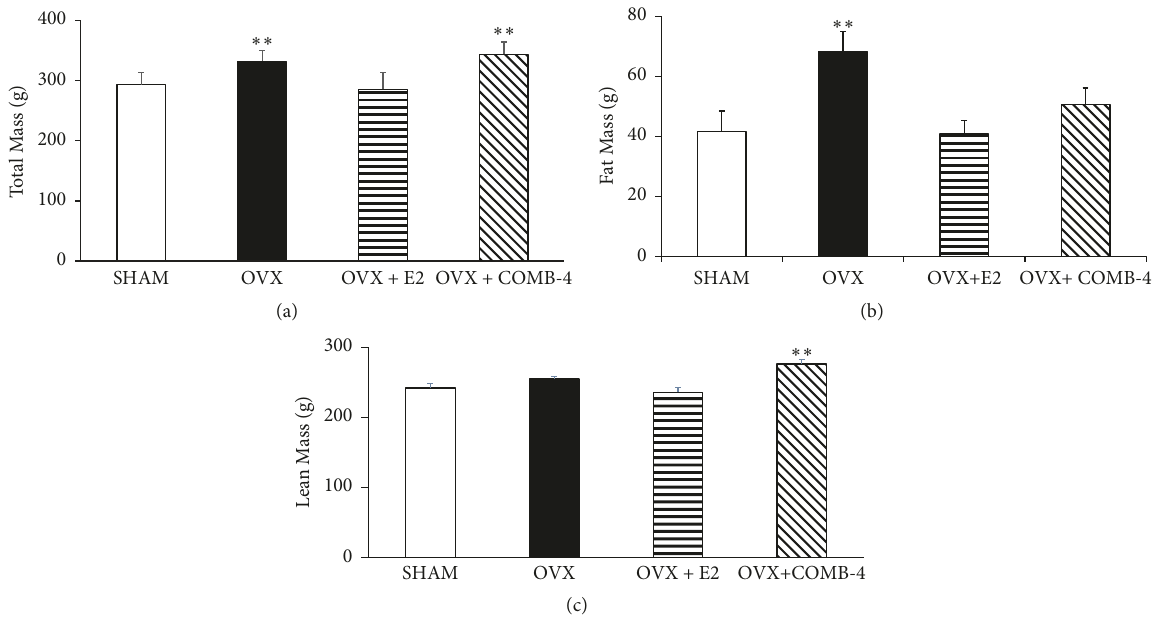
Figure 1: Effect of 100 days treatment with E2 or COMB-4 on Total Body Mass, Fat Mass, and Lean Mass following OVX. Whole body dual energy X-ray absorptiometry (DXA) scan performed 100 days following surgery and subsequent treatment with either vehicle (SHAM and OVX), E2 (OVX + E2) or COMB 4 (OVX + COMB-4). Panel (a): total body mass (g ± SEM); ∗∗ p < 0.01 with respect to SHAM and E2. Panel (b): total fat mass (g ± SEM); ∗∗ p < 0.01; with respect to SHAM, E2, and COMB-4. Panel (c): total lean mass (g ± SEM) ∗∗ p < 0.01 with respect to SHAM, OVX, and E2. n = 8 per